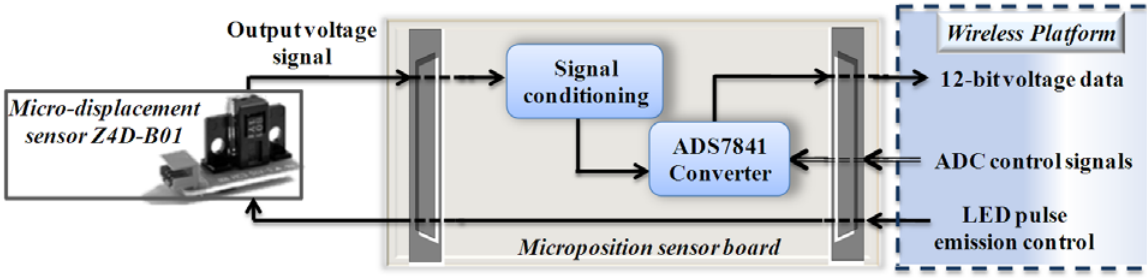
Figure 12. Block diagram for micro-displacement sensor